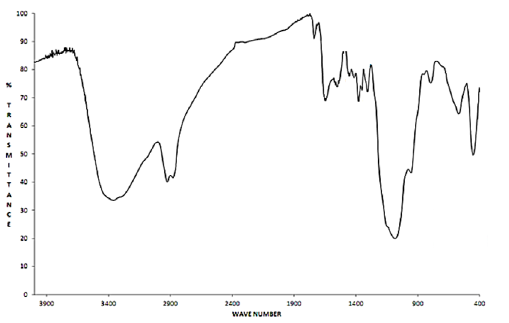
Fig. 1. FTIR spectrum of CS/gelatin